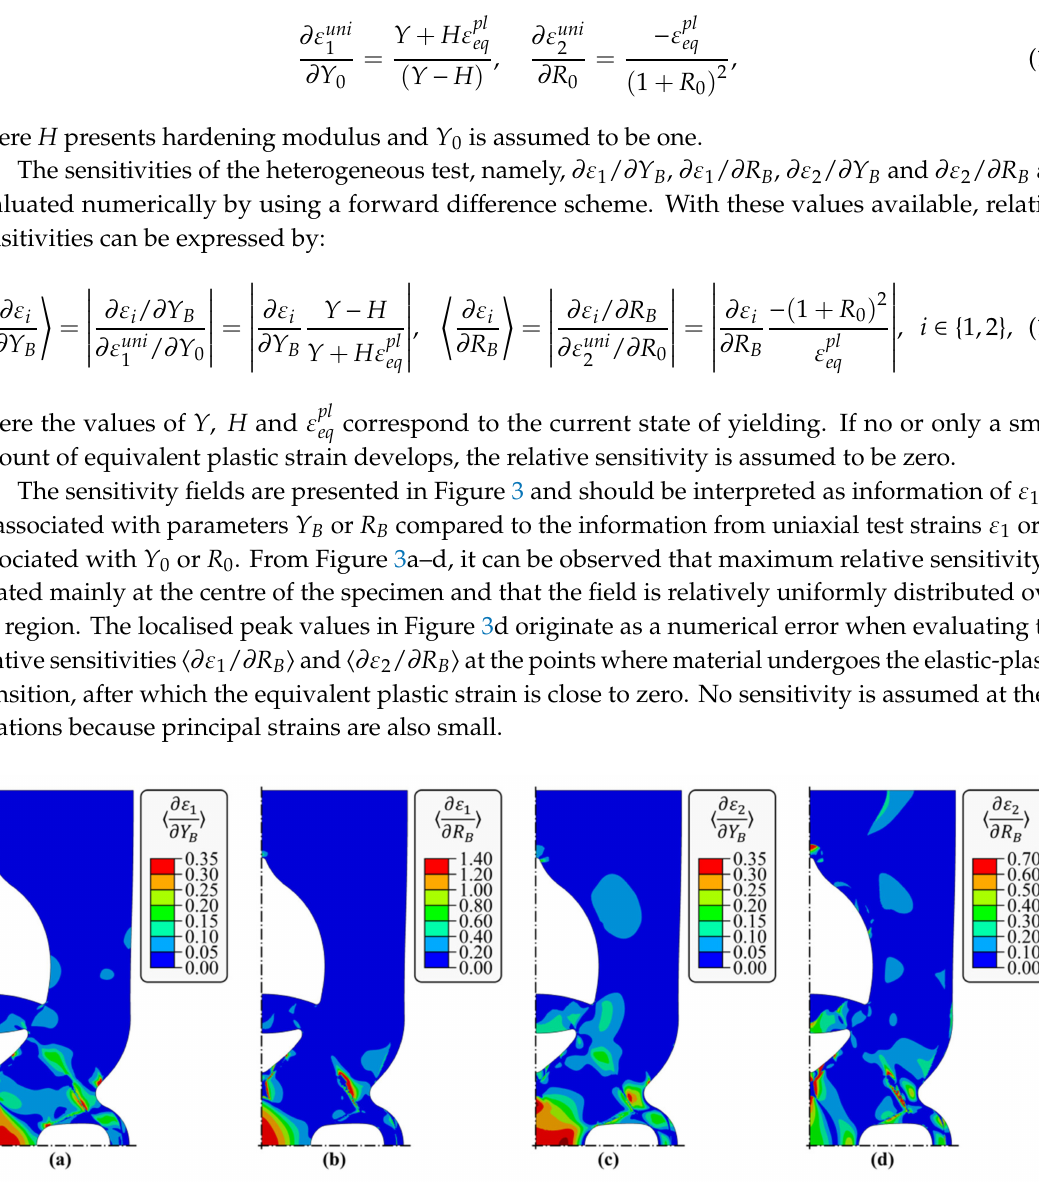
Figure 3. Heterogeneous test relative sensitivity fields: ( a ) relative sensitivity of max. principal strain ε 1 to a change of Y B , ( b ) relative sensitivity of max. principal strain sensitivity of min. principal strain ε 2 to a change of Y B , ( d ) relative sensitivity of min. principal strain ε 2 to a change of R B